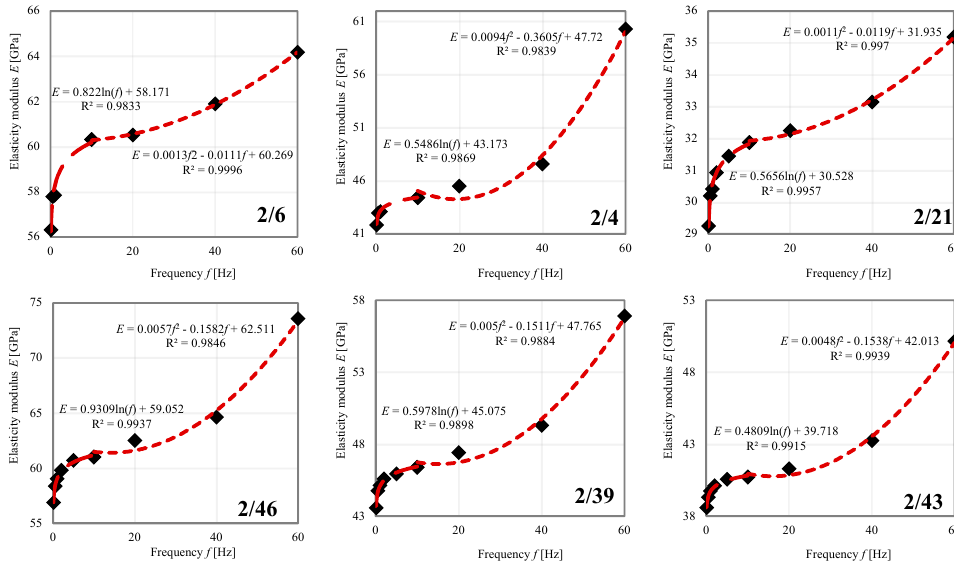
Figure 15. Dynamic modulus of elasticity of dry limestone samples.